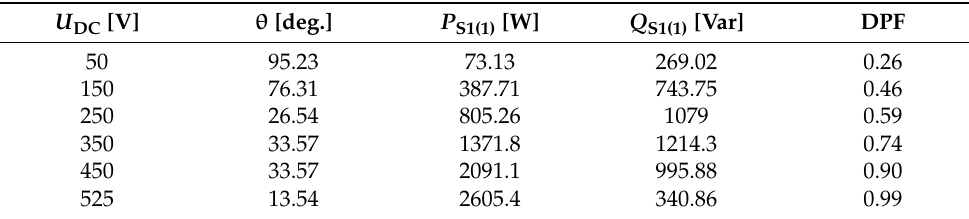
Table 7. Parameters of the fundamental harmonic active and reactive powers as well as DPF for different rectifier firing angles measured at the